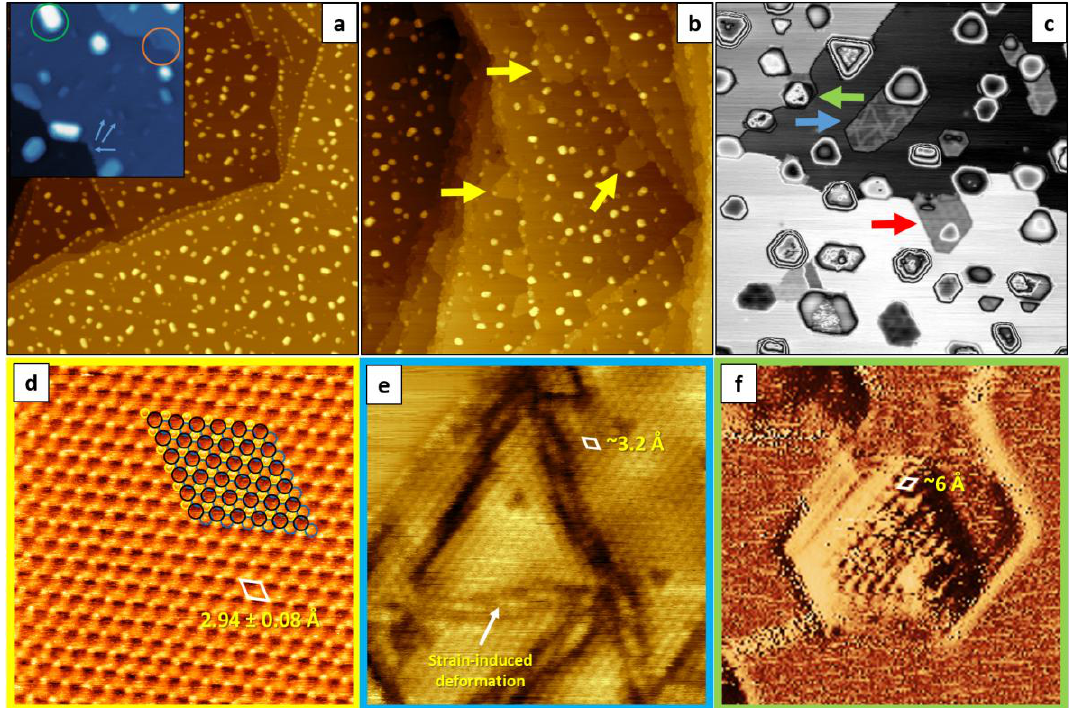
Figure 3. Large-scale topographic STM images (300 × 300 nm 2 ) of 0.5 ML Fe deposited onto Ag(111) substrate kept at 550 K ( a ) and subsequently oxidized in 1 × 10 −6 mbar O 2 at 700 K ( b ). The inset in ( a ) (50 × 50 nm 2 ) shows Fe inclusions in Ag(111) at regular terrace sites (marked with blue arrows) and step edges (orange circle), as well as bcc Fe(110) crystallite (green circle) observed on low-coverage HT-Fe/Ag(111) sample. The yellow arrows in (b) show the reconstruction-free islands. ( c ) shows small-scale image (100 × 100 nm 2 ) with various reconstructed surface regions (marked with green, blue and red arrows). ( d ), ( e ) and ( f ) show atomically-resolved STM images of the structures marked with colors in (b) and (c) (5 × 5 nm 2 , 10 × 10 nm 2 and 15 × 15 nm 2 , respectively). The unit cells are marked with white rhombuses (see text for details). Tunneling parameters: +0.7 V (a,b,c,e,f, inset in (a)) and +0.1 V (d), 1.0 nA (a) and 0.4 nA (b,c,d,e,f, inset in (a)); (d)—sum of topography and current